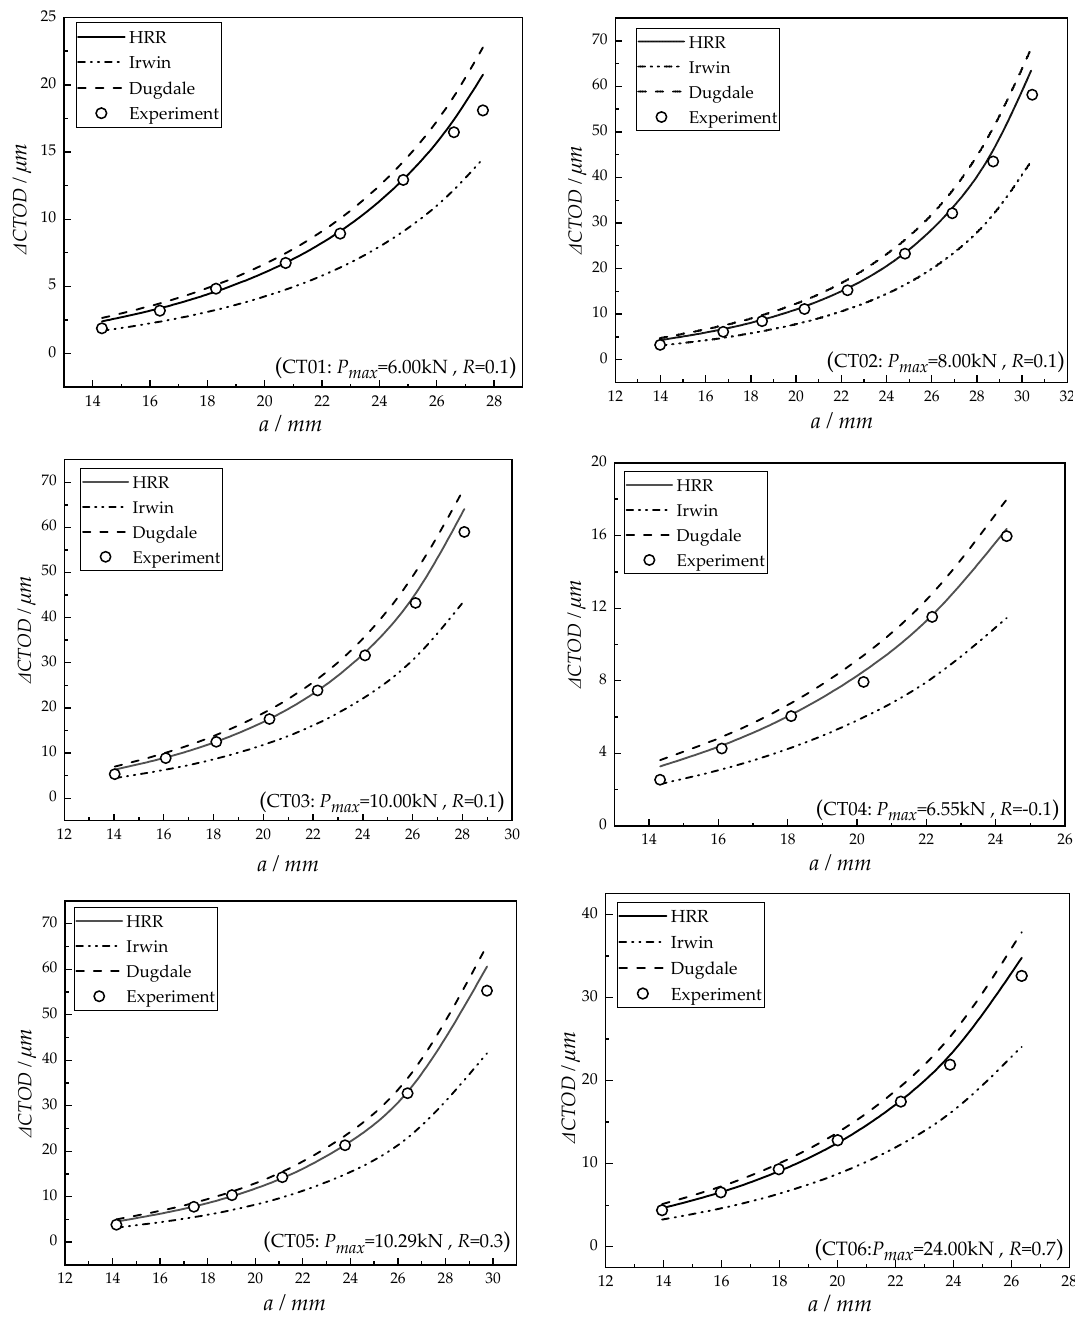
Figure 9. Numerical and experimental a-da/dN curve under all loading conditions.